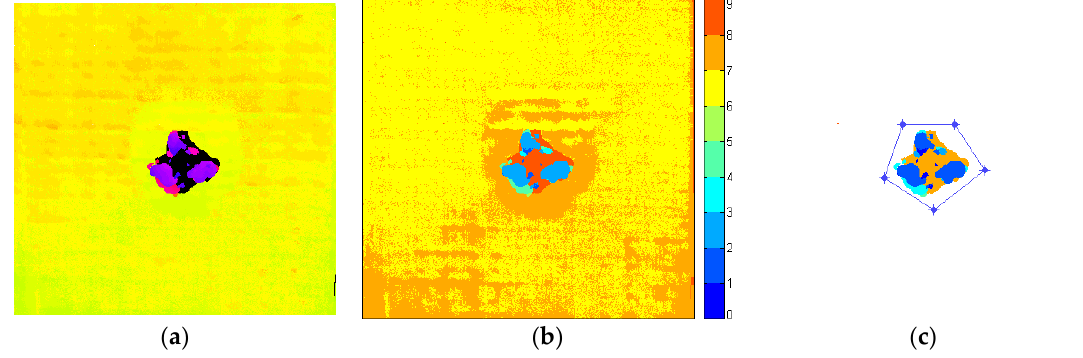
Figure 10. A general reconstruction algorithm for UT C-Scans.